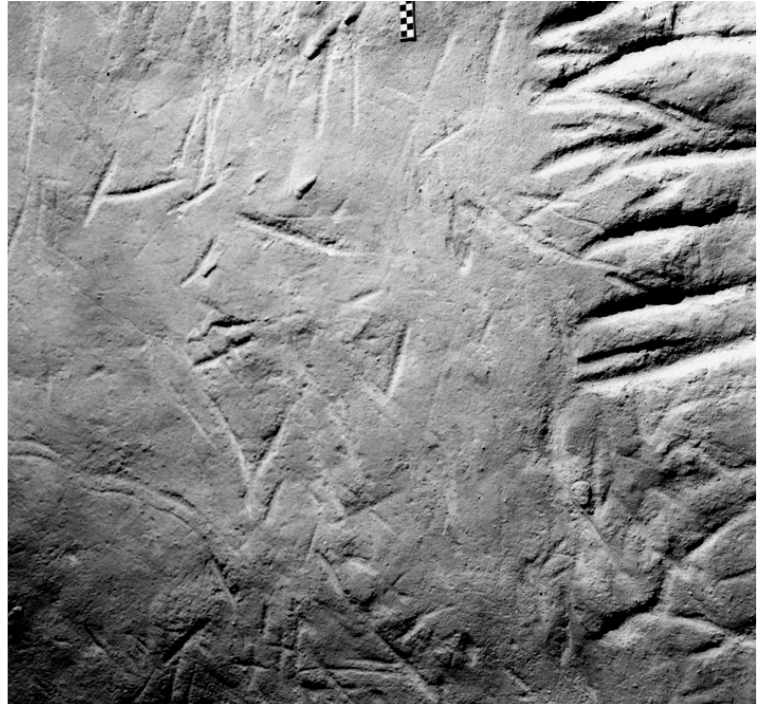
Figure 6. Engraved grooves on bedrock of Cueva Epullán Grande, Neuquén Province, Argentina, probably more than 9970 ± 100 years old (after Crivelli M. and Fernández